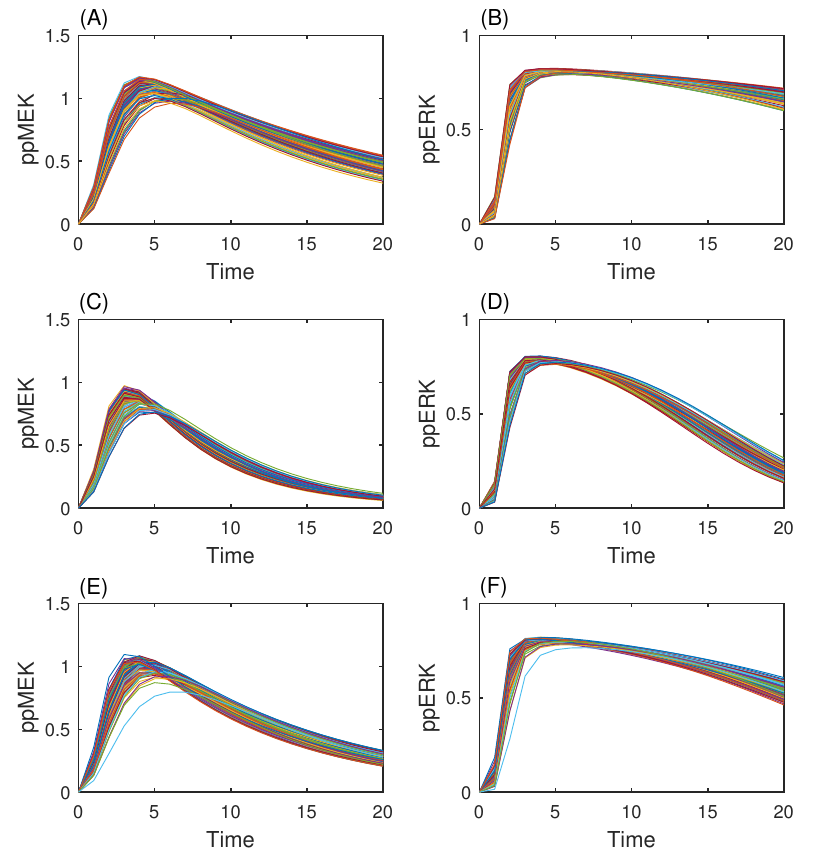
Figure 7. Simulations of ppMEK and ppERK in 3 clusters out of the total of 12 clusters. ( A , B ) Simulations of Cluster 4, which has 87 simulations. ( C , D ) Simulations of Cluster 6, which has 113 simulations. ( E , F ) Simulations of Cluster 11, which has 139